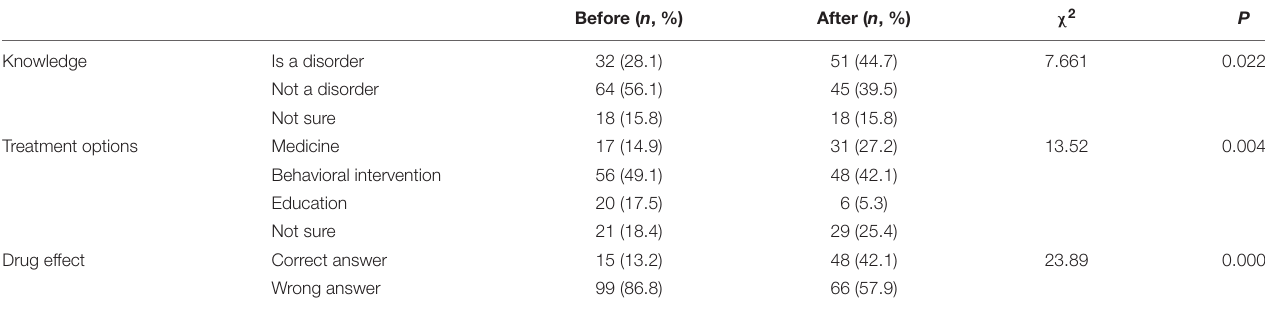
TABLE 4 | Parents’ knowledge, treatment options, and drug effect toward treatment before and after training (intervention group). Before ( n , %) After ( n , %) χ 2